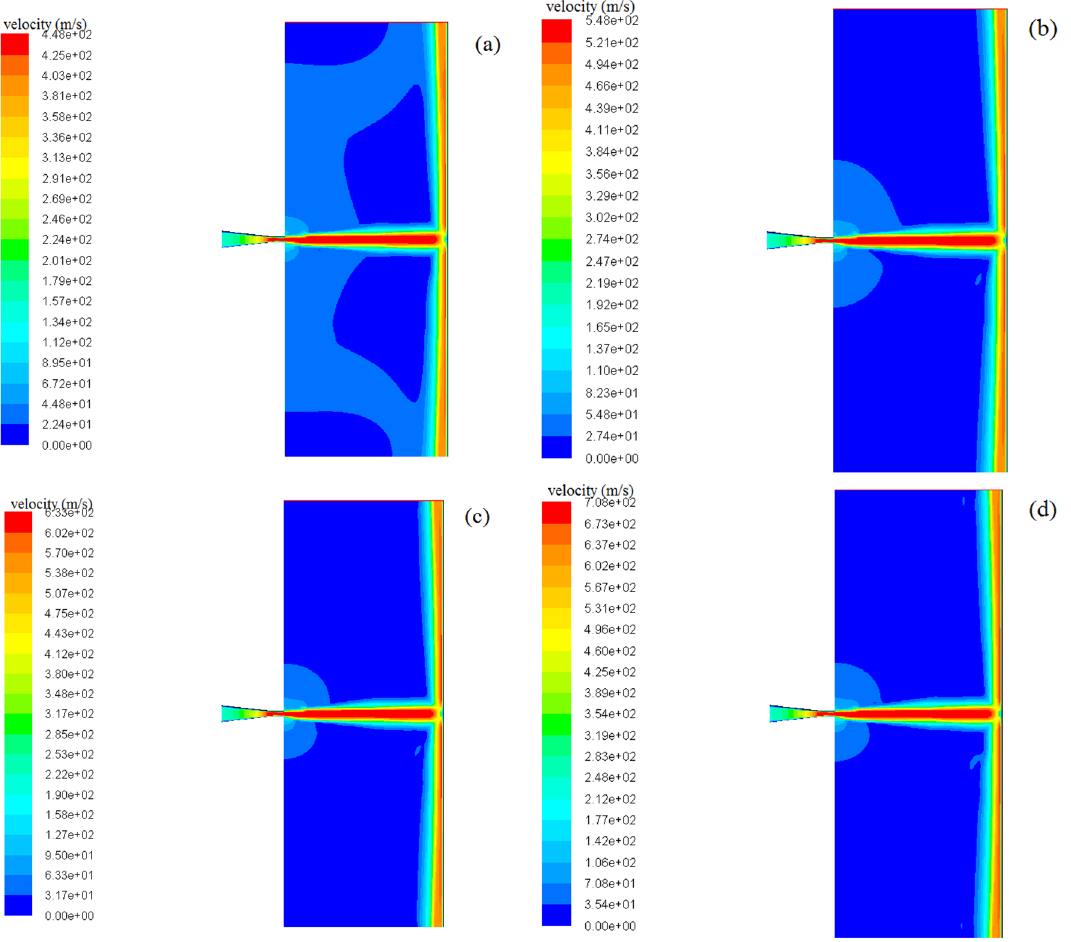
Figure 10. Predicted velocity cloud chart under various inlet water pressures ( a ) 100 MPa; ( b ) 150 MPa; ( c ) 200 MPa; ( d ) 250 MPa.